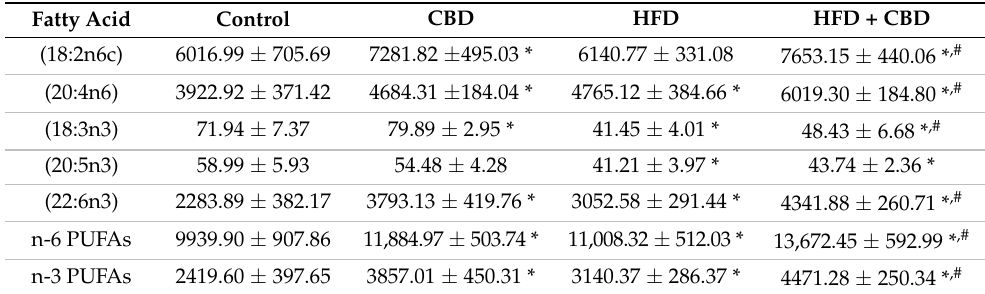
Table 8. Polyunsaturated fatty acids (PUFA) content in the PL fraction (nmol/g of wet tissue) in the red gastrocnemius muscle in the control (standard diet) and high-fat diet (HFD) groups after two-week cannabidiol (CBD)